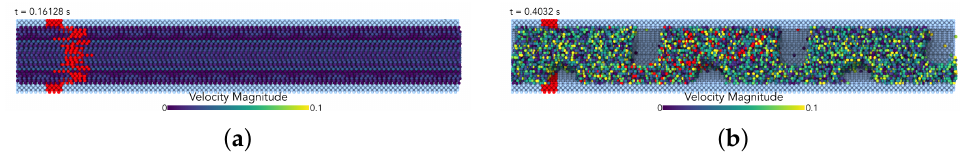
Figure 26. Unstable Bingham flow obtained with (cid:101) CS = 1 × 10 − 12 . ( a ) Timelines at t = 0.16 s after the start of the simulation. ( b ) Timelines at t = 0.40 s. Flow obtained with: (cid:101) CS = 1 × 10 − 12 , ρ = 1 × 10 3 , c = 1 × 10 − 1 , µ = 1 × 10 − 6 , g = 1 × 10 − 1 .